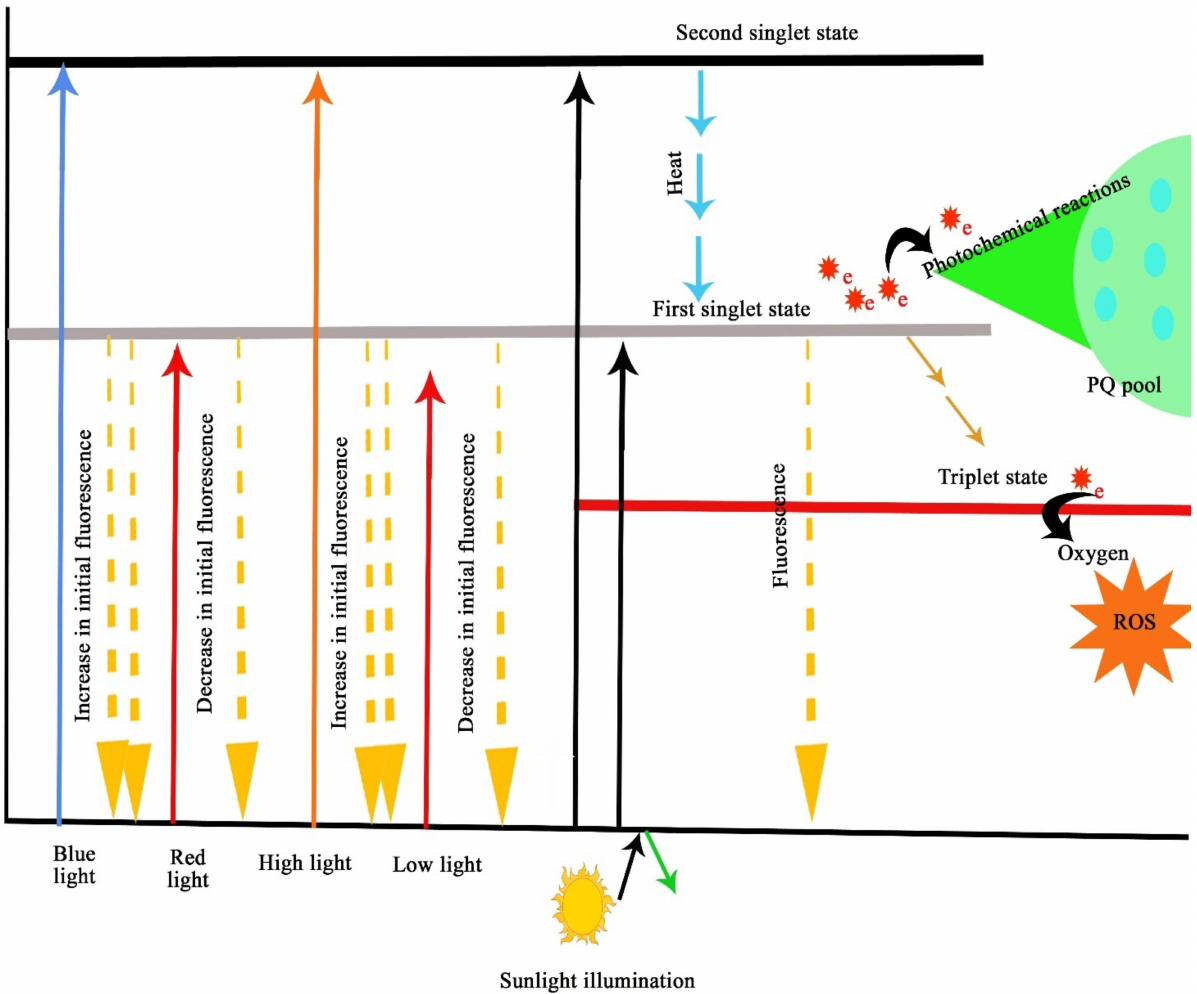
Figure 3. Mechanism of chlorophyll fluorescence in relation to light